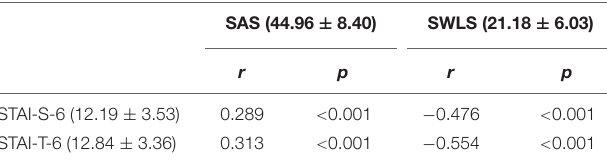
TABLE 10 | Correlations of STAI-S-6 and STAI-T-6 scores with SAS and SWLS scores among participants without anxiety ( n =